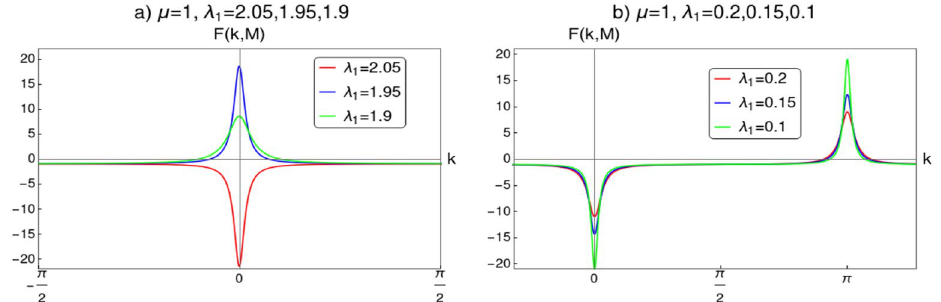
Figure 9. Curvature function F ( k , M ) near the multi-critical points. ( a ) Curvature function is plotted around the multi-critical point ‘b’ in the phase diagram, which distinguish between the distinct gapless phases (CP-1 (cid:31) µ and CP-2) on the critical line (cid:31) 2 1 . ( b ) Curvature function is plotted around the multi-critical point ‘a’ in = − 1 the phase diagram. Both are plotted for several values of (cid:31) 1 at µ =